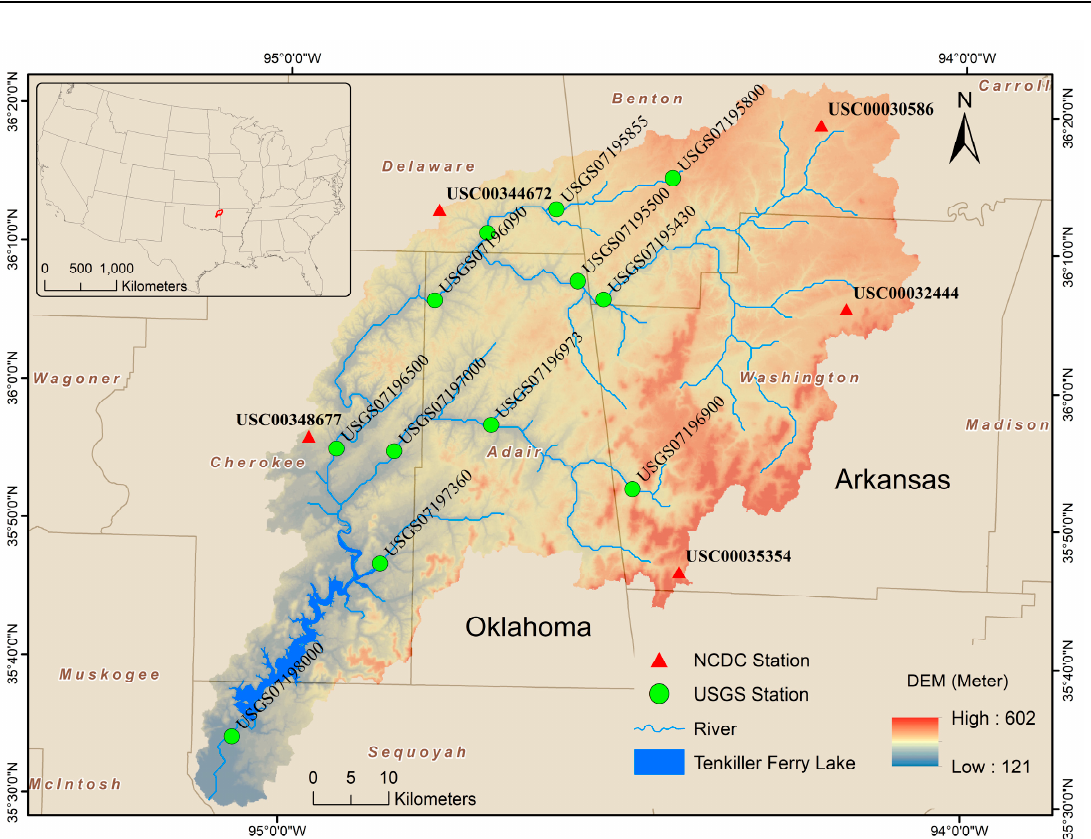
Figure 2. The geographic distribution of NCDC meteorological stations, USGS hydrological stations, lakes, and rivers in the IRW.